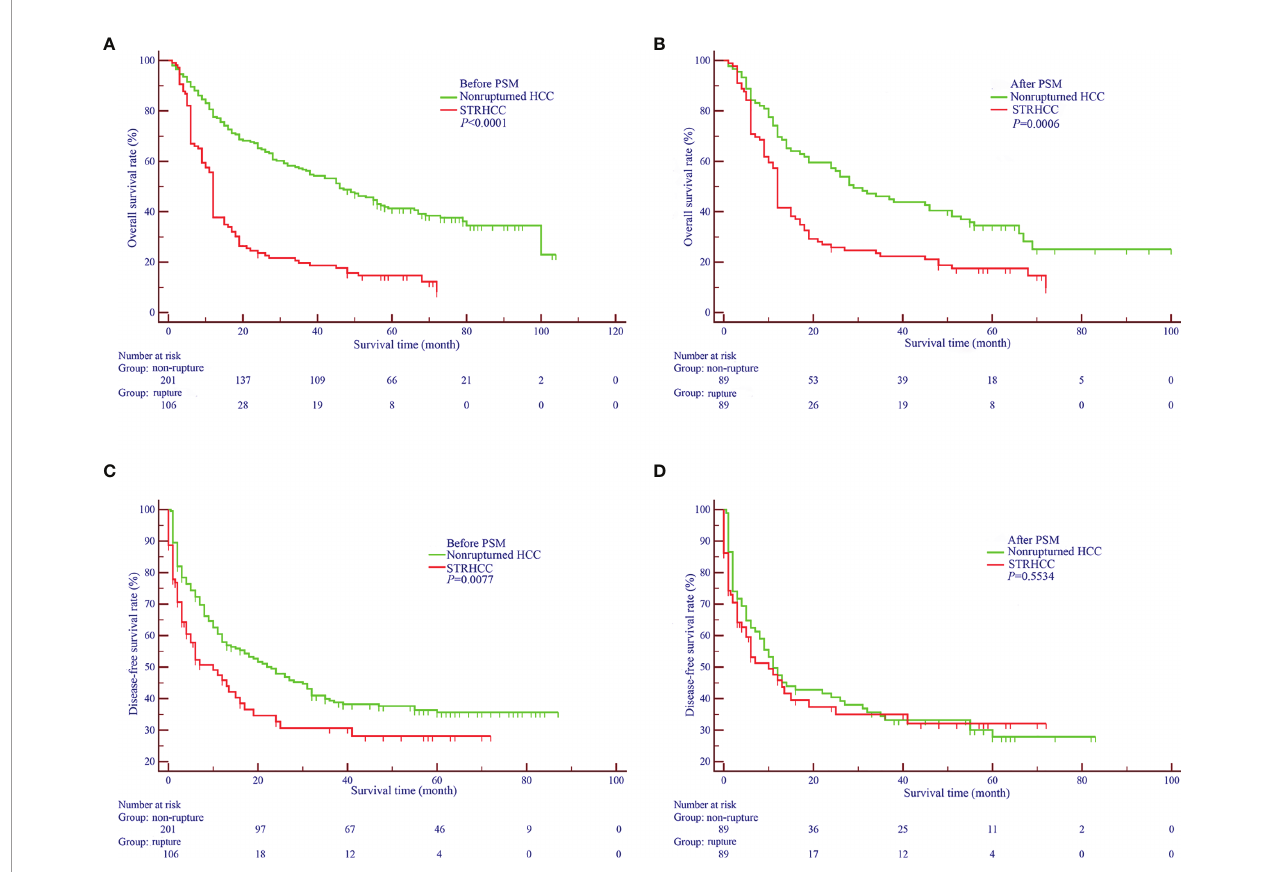
TABLE 3 | Cox regression analysis of prognostic factors of OS and DFS in 307 HCC patients (before PSM). Variates SE Wald Exp(B) 95%CI P value OS Tumor diameter ( ≥ 5cm vs. < 5cm)